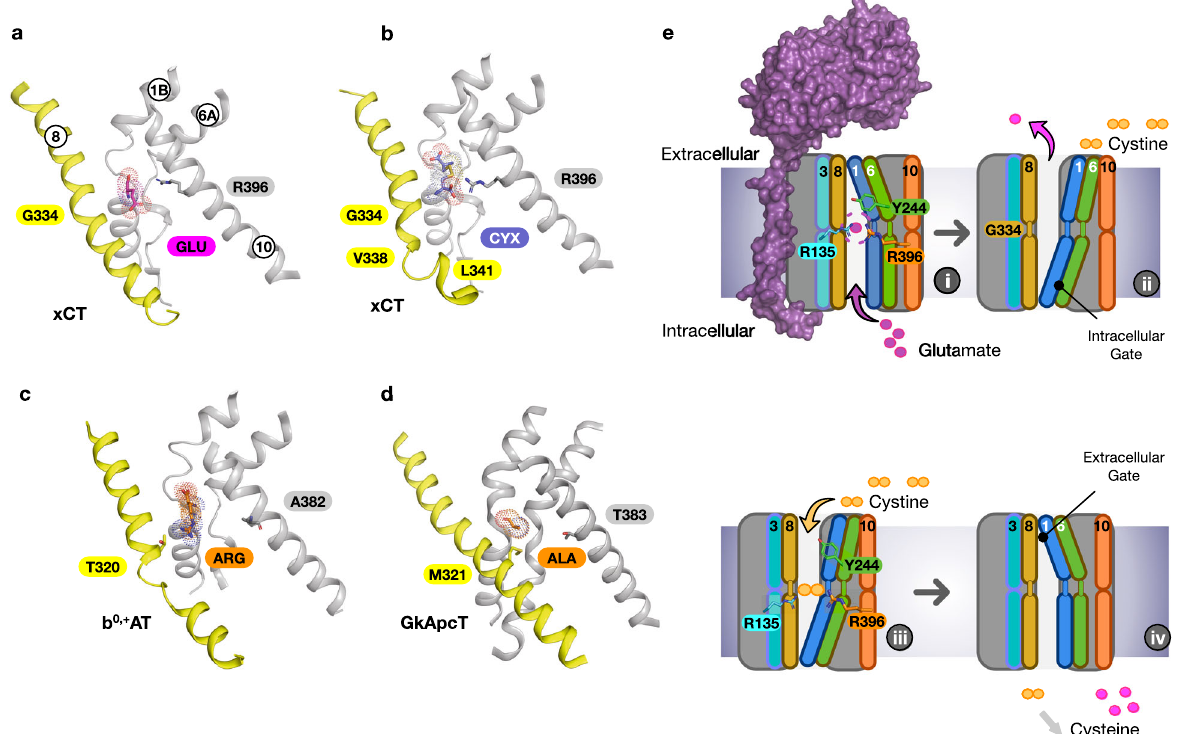
Fig. 5 Mechanism for cystine-glutamate recognition and antiport by system xc − . Comparison of the binding site in xCT bound to L -glutamate ( a ) and + , AT (PDB:6li9) ( c ) and GkApcT (PDB:5oqt) ( d ) highlighting the structural differences in TM8. Side chains L -cystine ( b ) with the L -Arginine bound b 0 discussed in the text are highlighted. e Key steps in the transport cycle for system xc − , as discussed in the